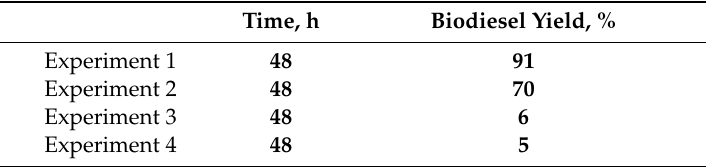
Table 2. Comparison of biodiesel yield obtained in batch